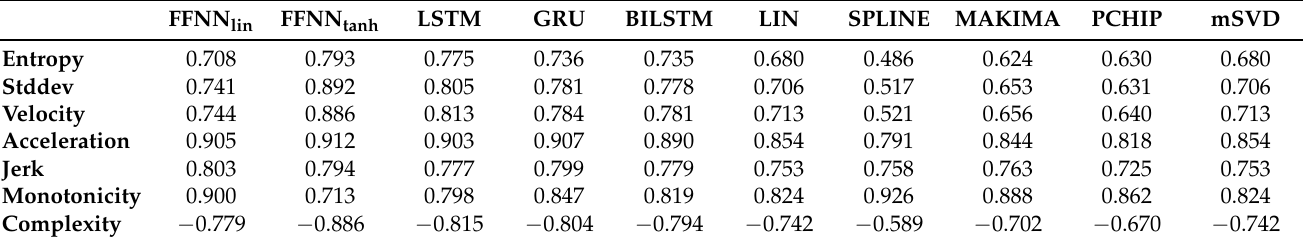
Table 5. Correlation between RMSE and sequence parameters (averaged for all gap sizes).